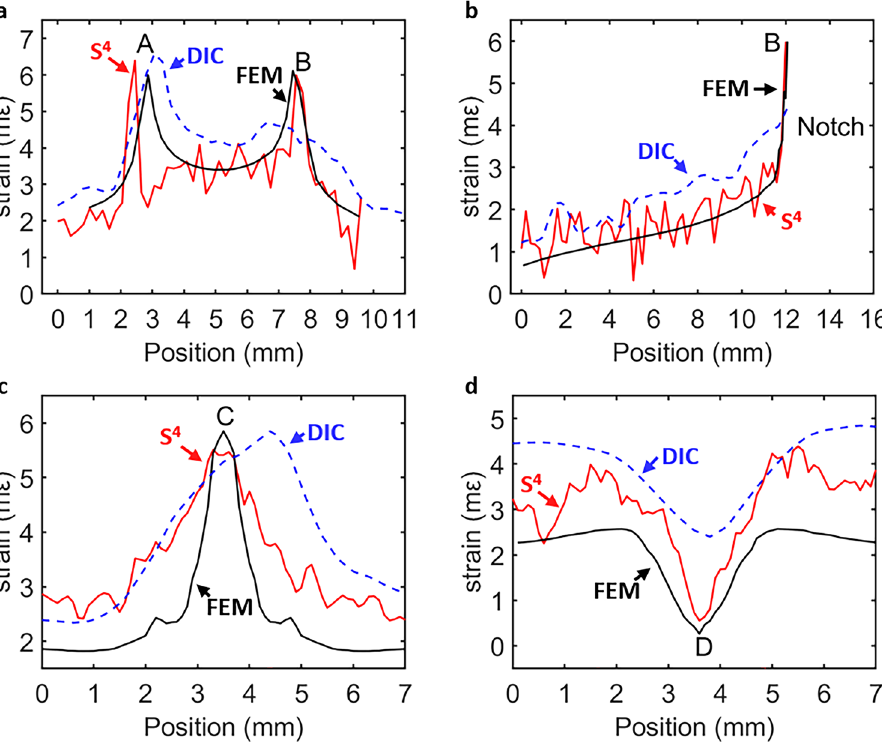
Figure 5. Strain profiles along ( a ) the line connecting points A and B in the top row of Fig. 4; ( b ) the horizontal line through point B in the top row of Fig. 4; ( c ) the vertical line through point C in the bottom row of Fig. 4; ( d ) the horizontal line through point D in the bottom row of Fig.